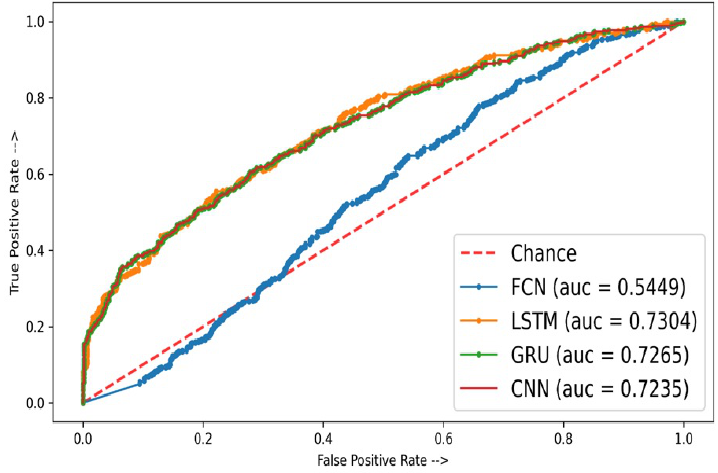
Figure 8. ROC-AUC for deep learning